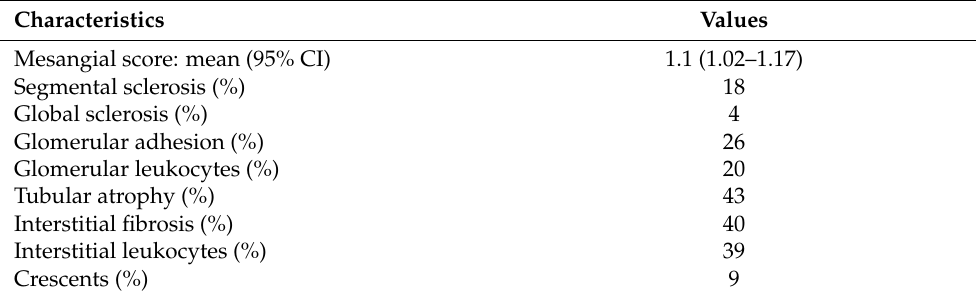
Table 2. Summary of the kidney pathology findings for 110 patients with IgA vasculitis with nephritis.